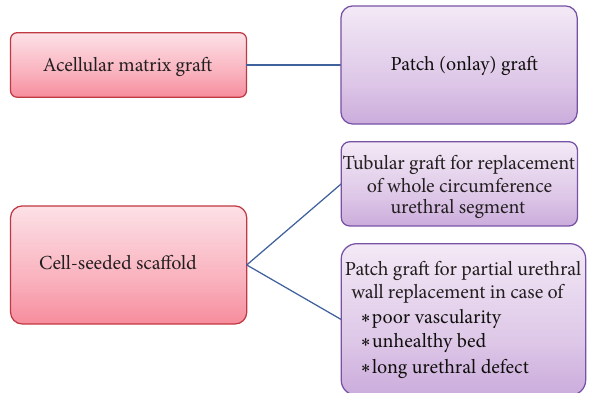
Figure 2: Strategies for urethral replacement using tissue engineer- ing